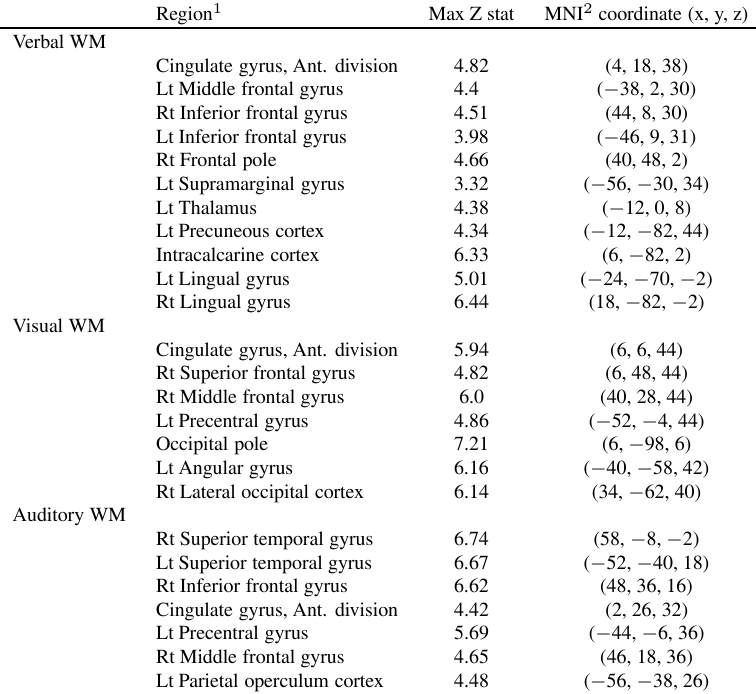
Table 1 Signi fi cant activations in each